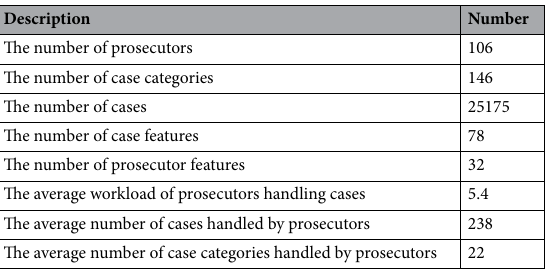
Table 1. Statistics of our